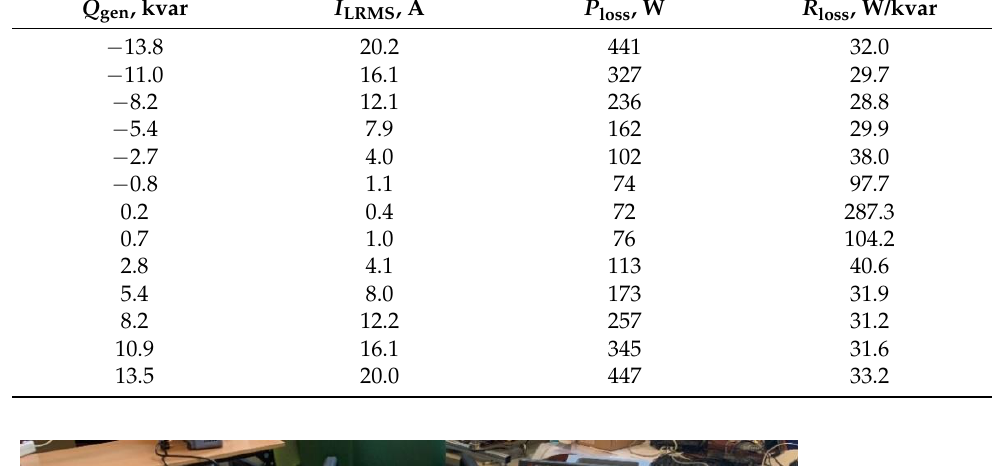
Table 2. Results of power losses measurement of APF operating in reactive power generation mode.